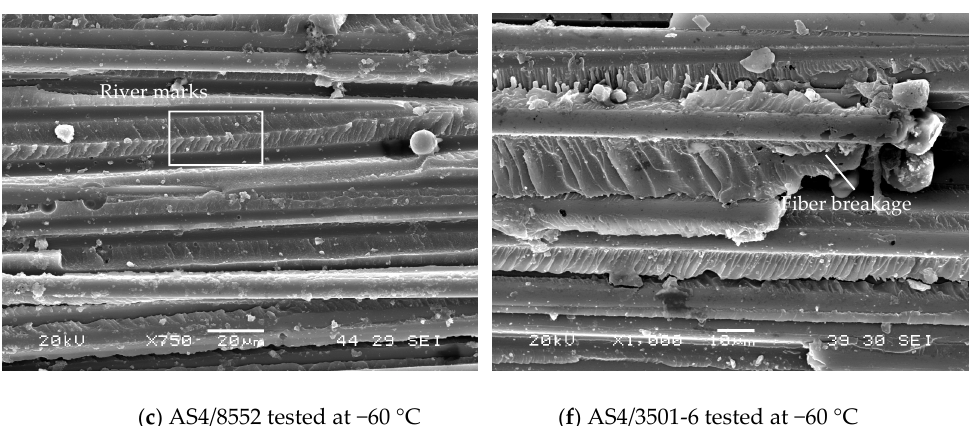
Figure 1. Micrographs obtained from the fractographic analysis for both materials at the different test temperature conditions